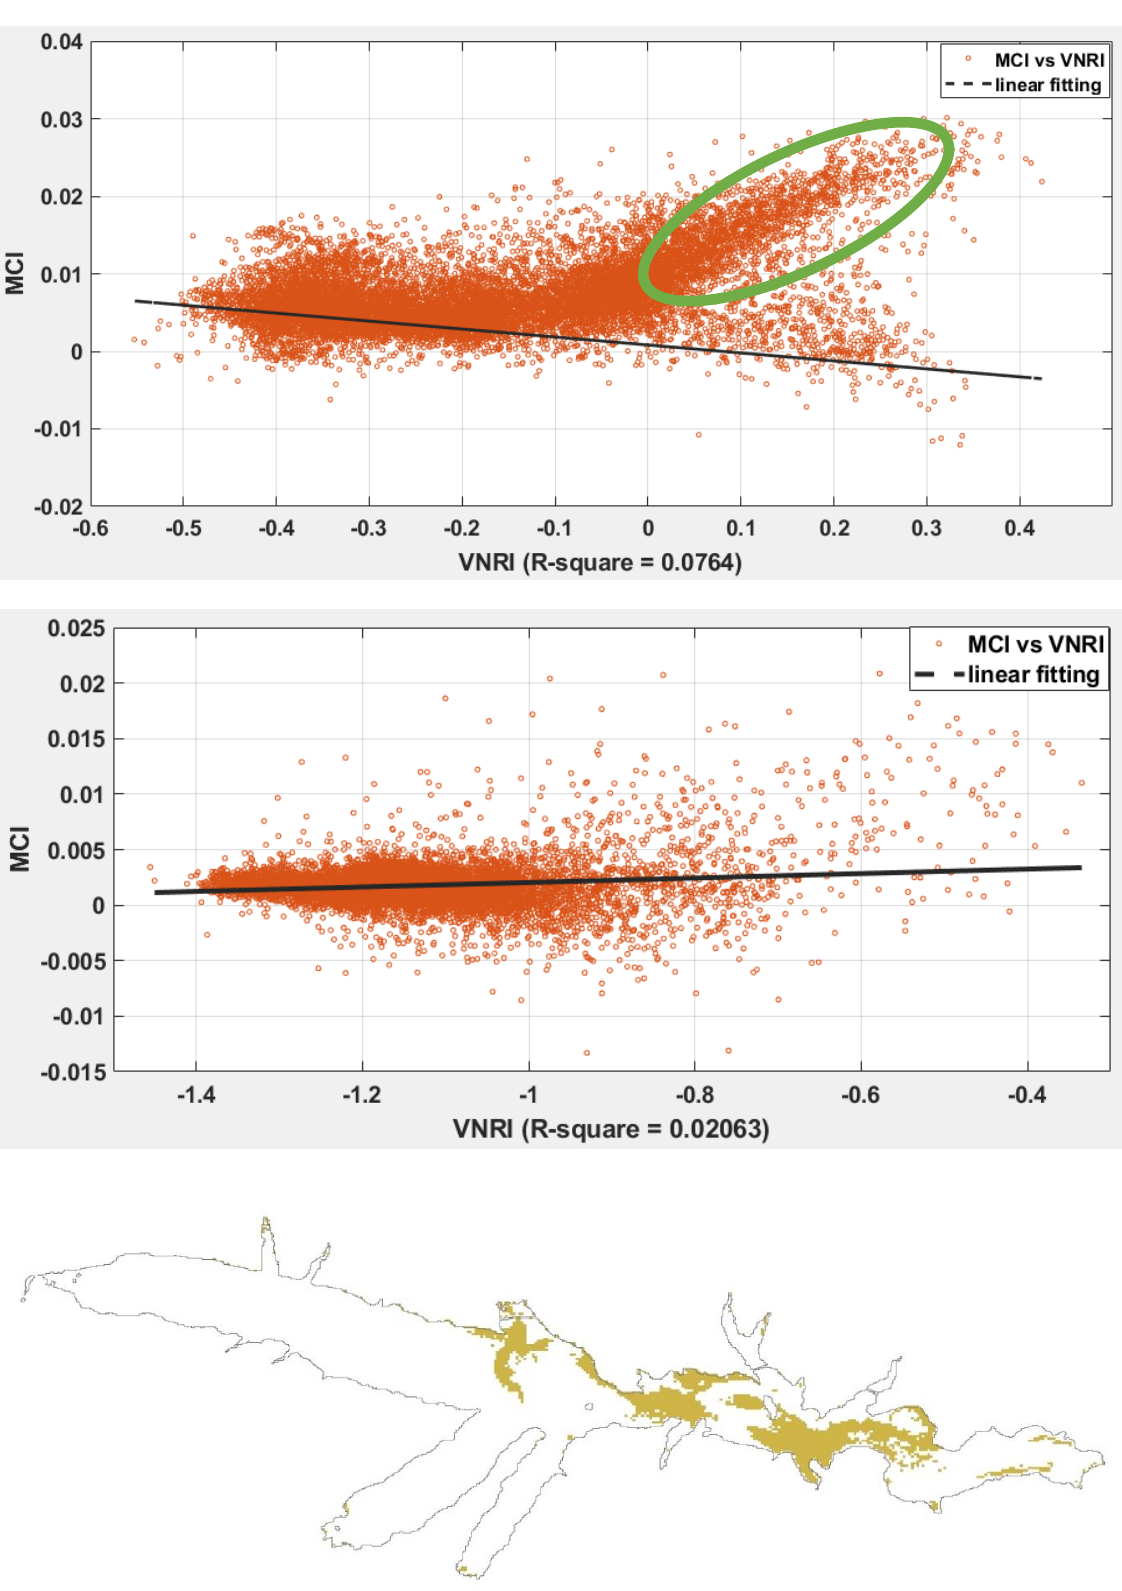
Figure 5. Comparison between VNRI and MCI values to check the correlation between indices. Plots are based on the analysis of the S2 images of 27 February 2017 ( top ) and 01 July 2021 ( middle ). ( Bottom ) image shows the area of the lake corresponding to the pixel values of the ascending branch (pixel values enclosed in the green ellipse) of the top plot.